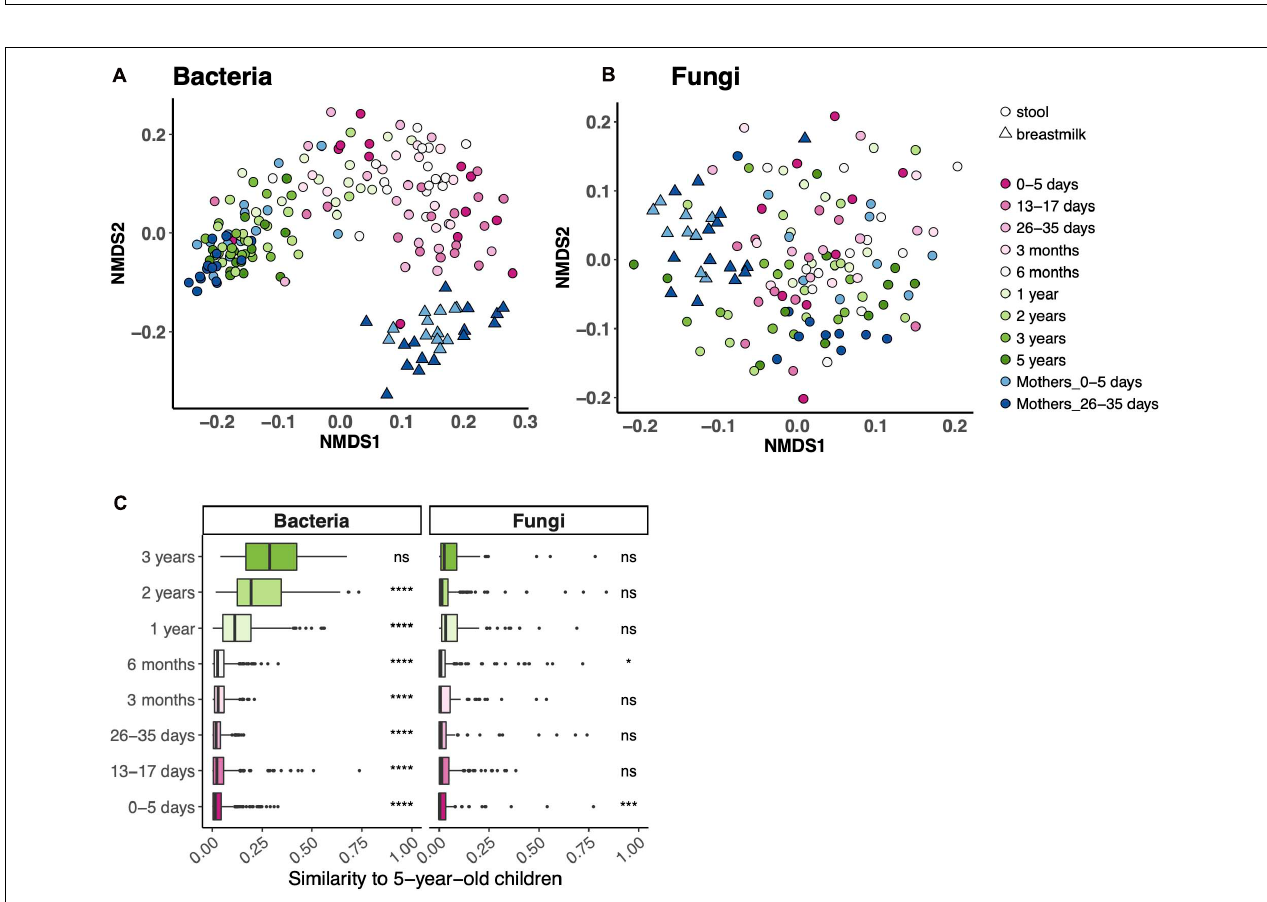
FIGURE 1 | Alpha diversity across the age spectrum for bacterial fecal communities (A) and fungal fecal communities (B) . Coding indicates values significantly different from those of adult communities (Mothers of 26–35-day-old newborns): **** p < 0.0001, *** p < 0.001, ** p < 0.01, * p < 0.05; Wilcoxon rank-sum test adjusted using the Bonferroni correction. Boxplots indicate medians with first and third quartiles (25–75%). Whiskers extend no farther than 1.5*IQR from the hinge.